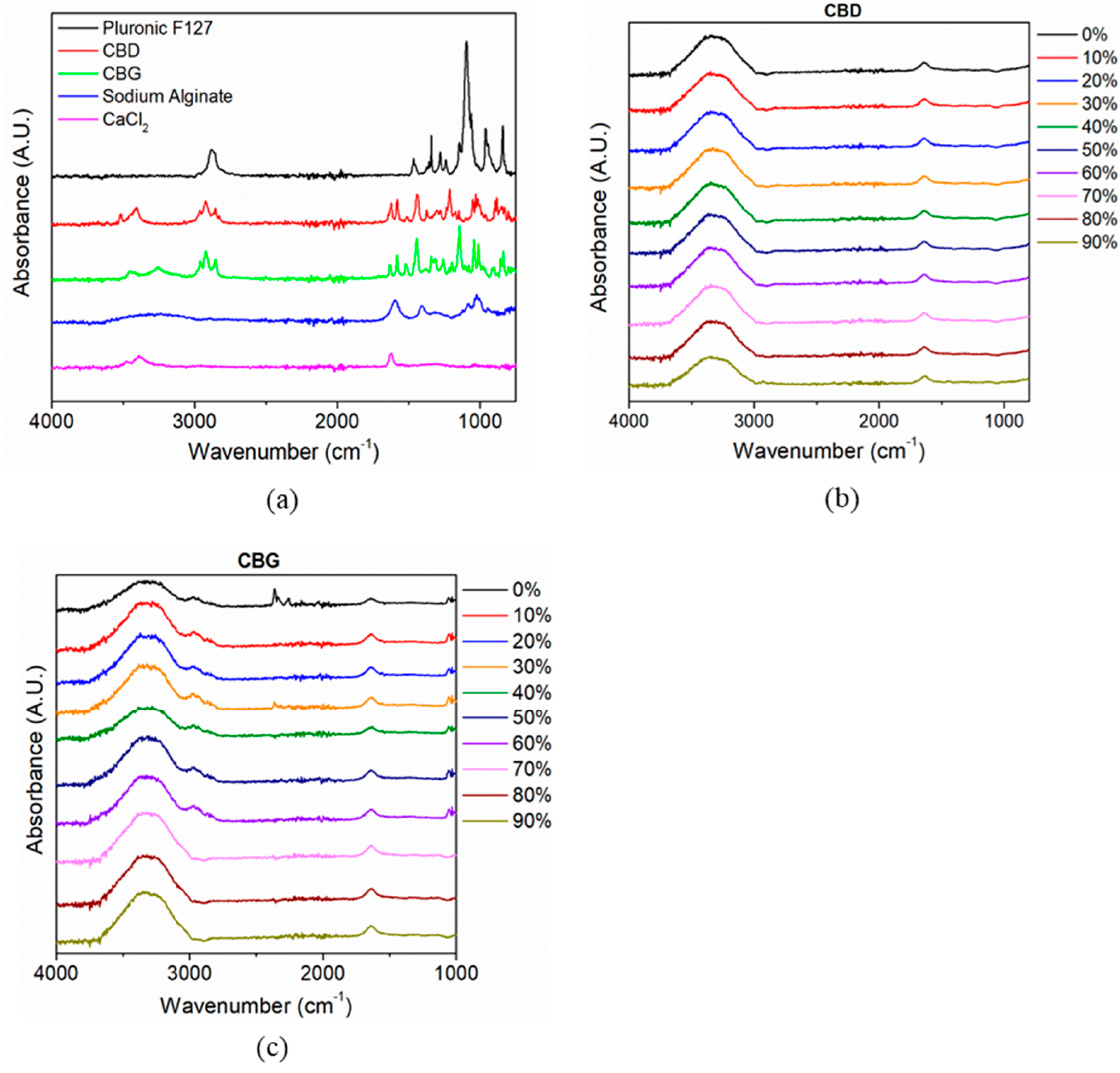
Figure 6. FT-IR spectra of ( a ) raw materials, ( b ) CBD dispersion and ( c ) CBG dispersion. FTIR analysis can also be used for studying the molecular interactions and chemical structure of CBD and CBG suspensions. The FTIR spectra for different ratios of